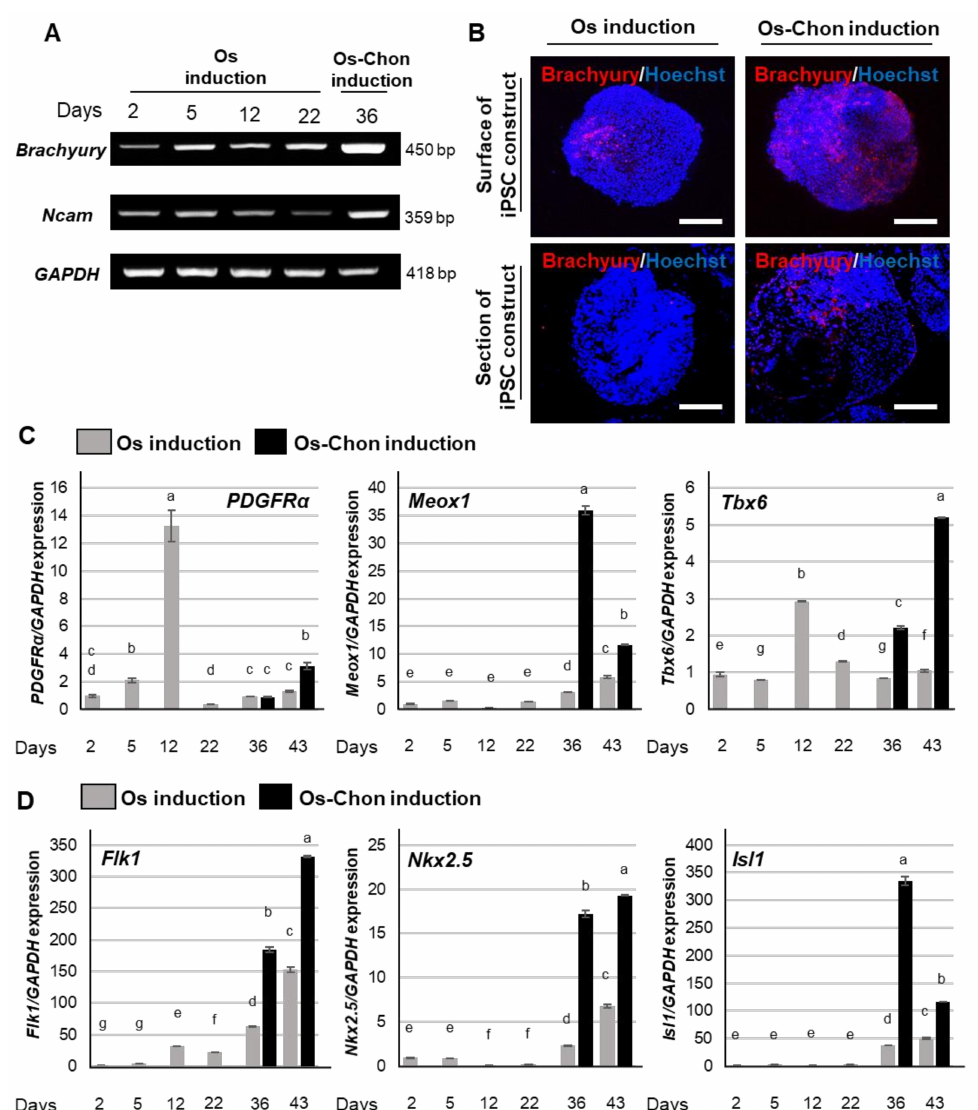
Figure 5. E ff ects of Os and Os-Chon induction on mesodermal lineage commitment in 3D-iPSC constructs. ( A ) Expression of early mesodermal marker genes, brachyury and Ncam , was evaluated by semi-quantitative RT-PCR analysis on day 2 (the day when the induction commenced), on day 5, 12, and 22 (Os induction; same induction protocol as Os-Chon induction during this period) and on day 36 (Os-Chon induction). GAPDH expression was used as an internal control. ( B ) Representative images of immunohistochemical staining for brachyury on the surface (upper panels) and in cross-sections (lower panels) of OI-iPSC and OCI-iPSC constructs at day 36 (nuclear counterstain with Hoechst). Scale bars; 200 µ m. Expression of ( C ) paraxial mesoderm marker genes ( PDGFR α , Meox1 and Tbx6 ) and ( D ) lateral plate mesoderm marker genes ( Flk1 , Nkx2.5 and Isl1 ) was evaluated by real-time RT-PCR. The data represent the mean ± SD ( n = 3). Di ff erent letters indicate significant di ff erences between groups ( p < 0.05, one-way ANOVA with Tukey’s multiple comparison test). GAPDH expression was used as an internal